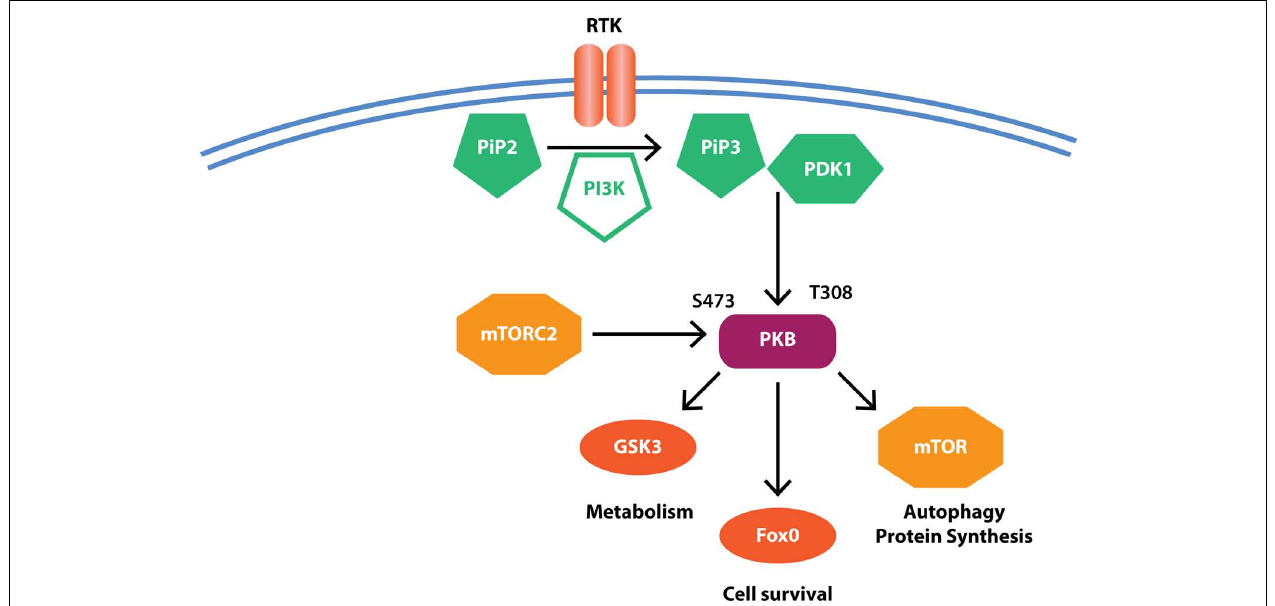
Ser473 by mammalian target of rapamycin (mTOR) complex 2 (mTORC2). PKB then further phosphorylates downstream